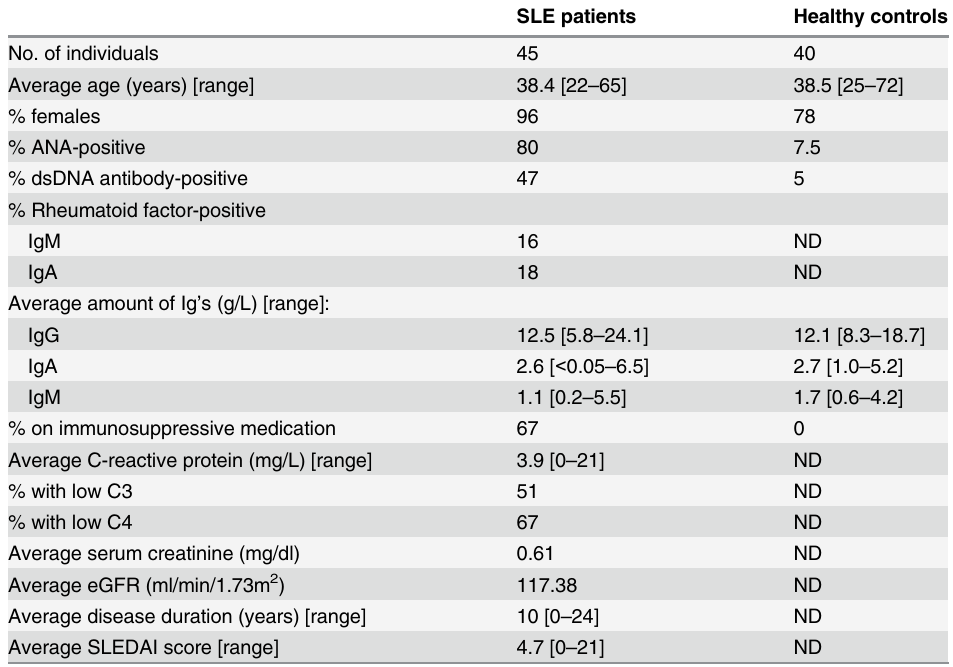
Table 1. Characteristics of SLE patients and healthy controls.